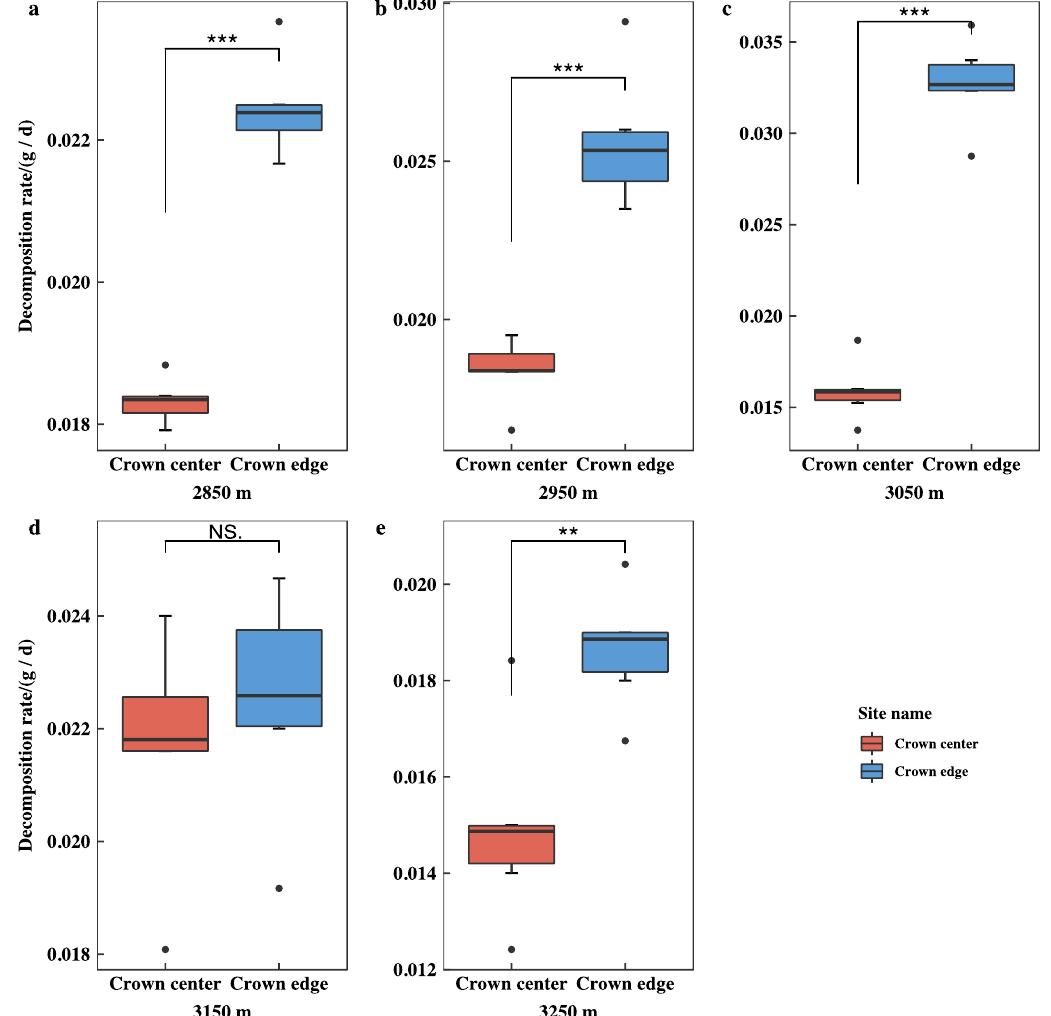
Figure 7. Initial decomposition rate (g · day − 1 ) of Qinghai spruce leaf litter from CC and CE at different altitudes in the growing season. ( a ) Represents the initial decomposition rate of Qinghai spruce leaf litter in 2850m CC and CE plots. ( b ) Represents the initial decomposition rate of Qinghai spruce leaf litter in 2950m CC and CE plots. ( c ) Represents the initial decomposition rate of Qinghai spruce leaf litter in 3050m CC and CE plots. ( d ) Represents the initial decomposition rate of Qinghai spruce leaf litter in 3150m CC and CE plots. ( e ) Represents the initial decomposition rate of Qinghai spruce leaf litter in 3250m CC and CE plots. Notes: Values are from bulk litter of CC and CE sites. n = 5. NS., p > 0.05; **, p < 0.0l; ***, p < 0.001.